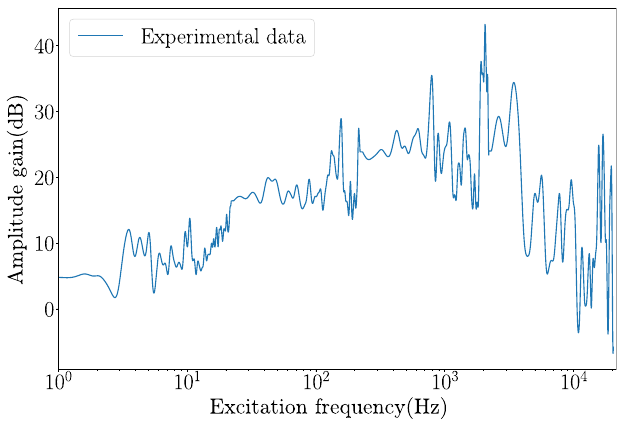
Fig. 8. Amplification (in dB) is plotted as function of the frequency at which a piezoelectric transducer excites the mem- brane. Amplification was derived from the difference of ampli- tude between the transducer vibrating alone and its action as it was put on the balloon. For convenience, a sweep of frequen- cies was performed. The distance to the microphone remains constant between the two sound samples.